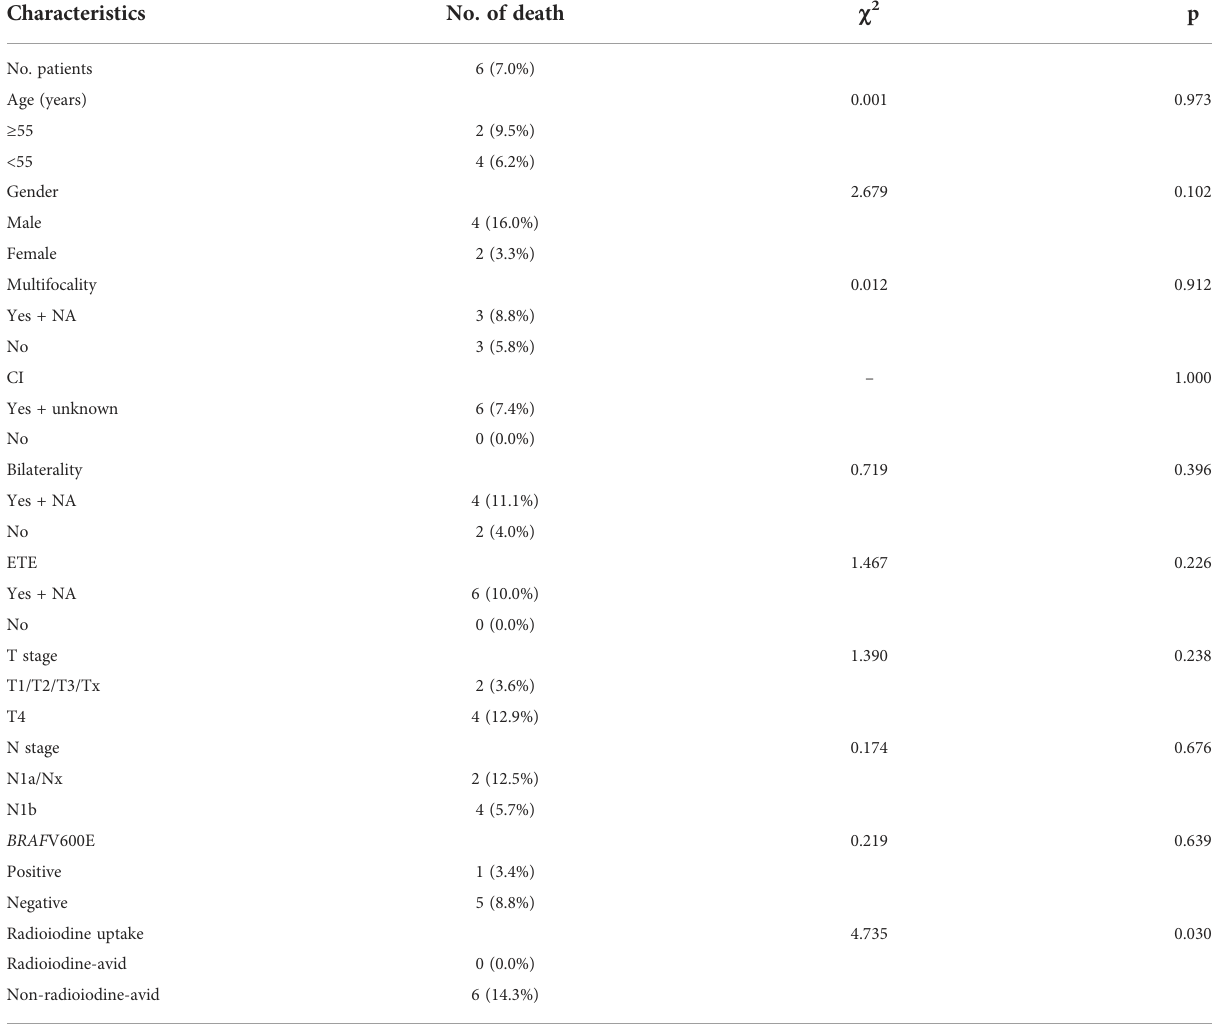
TABLE 6 Univariate chi-square analysis of prognostic factors of mortality in 86 patients.